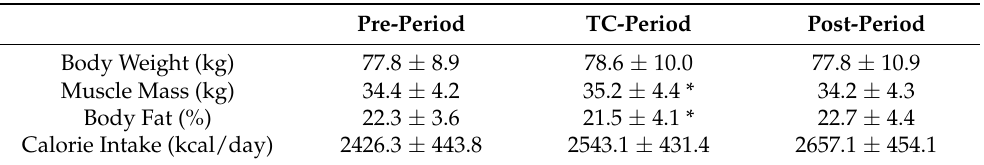
Table 1. Comparison of whole body composition and caloric intake in each period. The values are expressed as means ± SD. * p < 0.05 vs. the Post-period values.